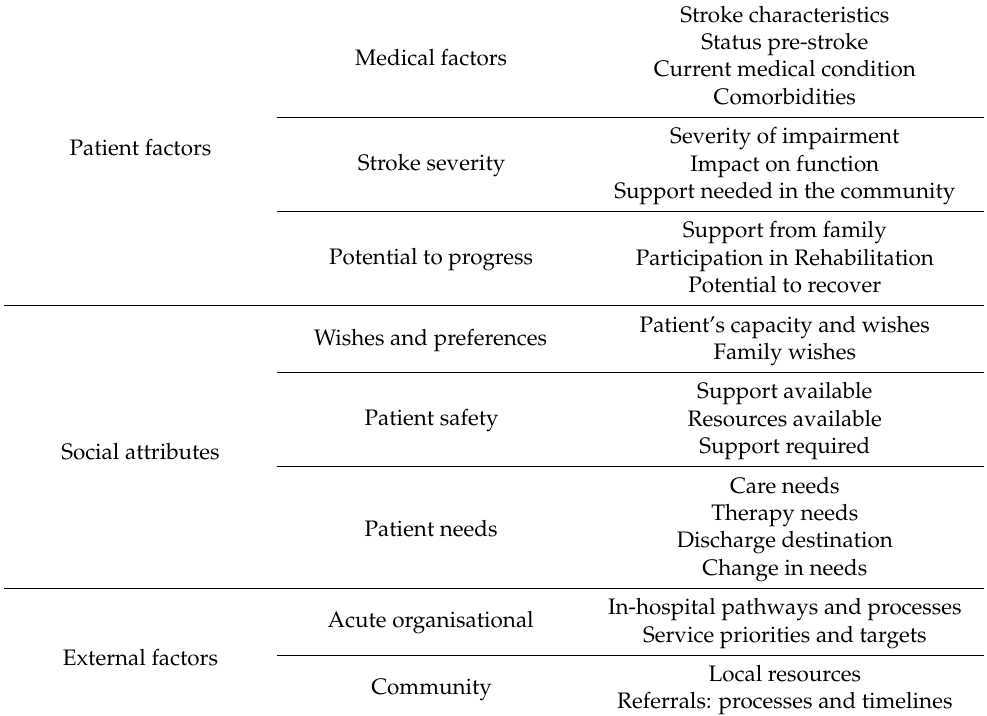
Table 1. Factors influencing decision-making for rehabilitation concerning stroke